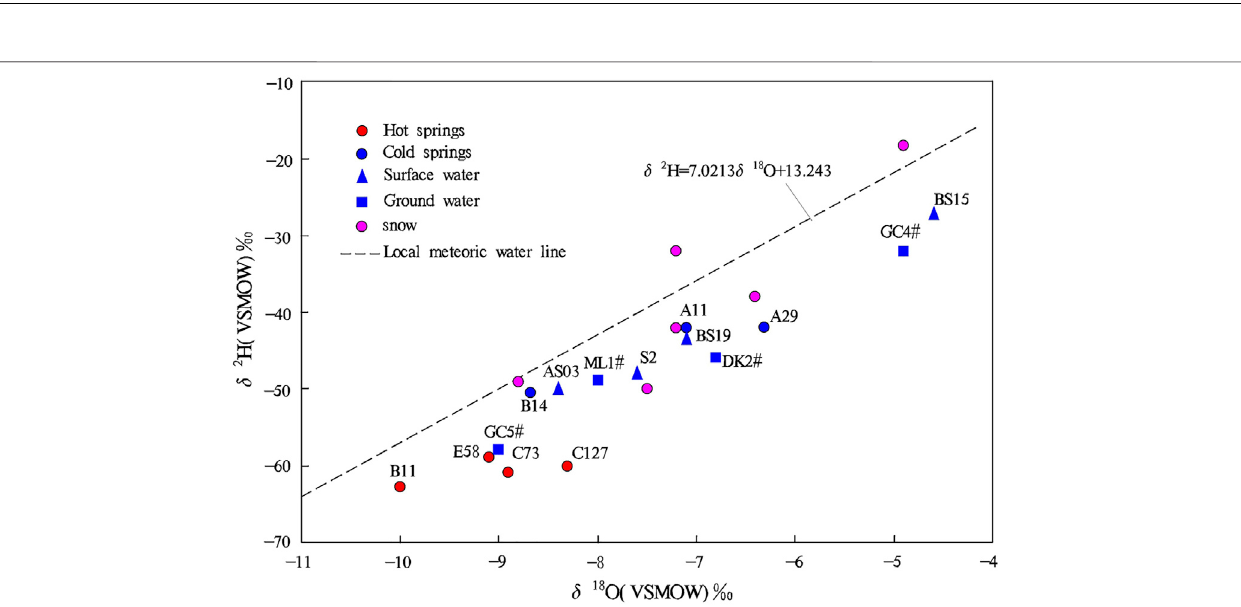
FIGURE 5 | δ 2 H vs. δ 18 O relationship of water samples from the Jiangcang